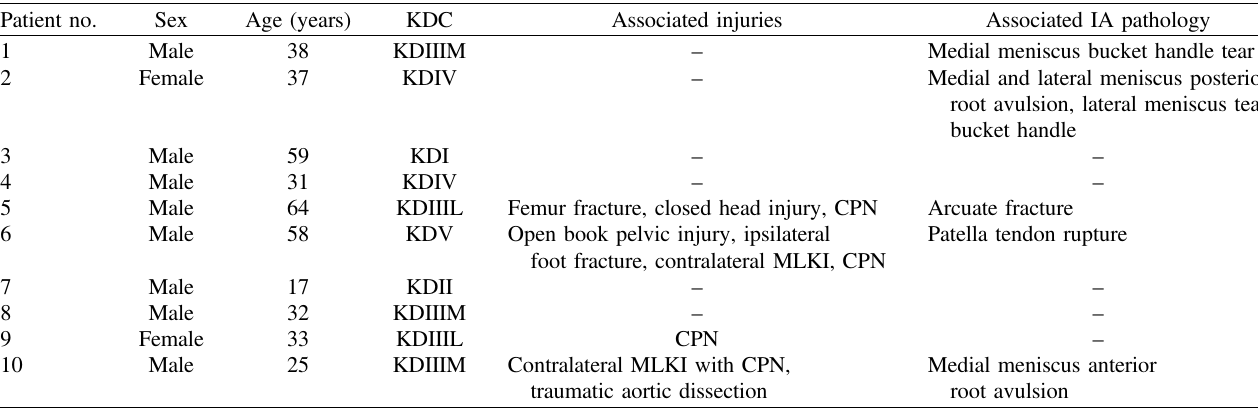
Table 1. Categorization of knee dislocations according to Schenck classi fi cation, and description of associated injuries. Patient